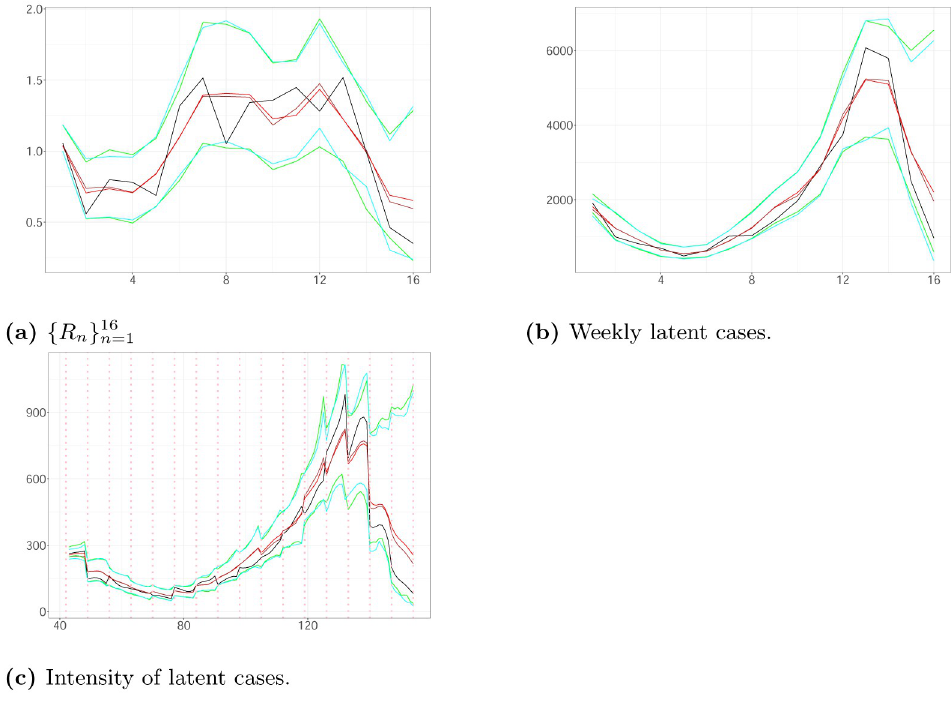
Fig 3. The true (black line) and the estimated weighs f R g 16 , weekly latent cases and latent intensity (with n n ¼ 1 estimated seeds (posterior median (brown line); 99% CI (cyan line)), and true seeds (posterior median (red line; 99% CI (green line))) in Scenario A plotted against time. The vertical dotted lines show the beginning of each week in the period we examine. (a) f R g 16 . (b) Weekly latent cases. (c) Intensity of latent cases. n n ¼ 1